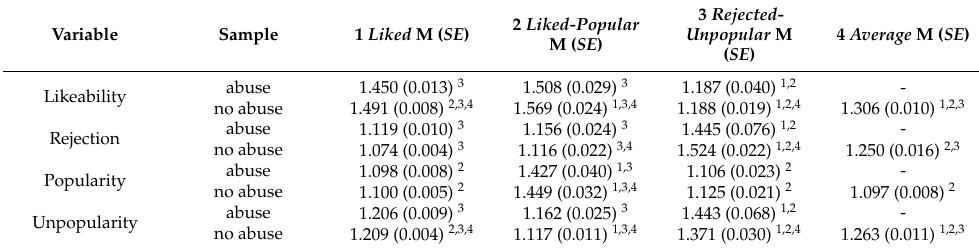
Table 4. Wald Test, means and standard errors of the